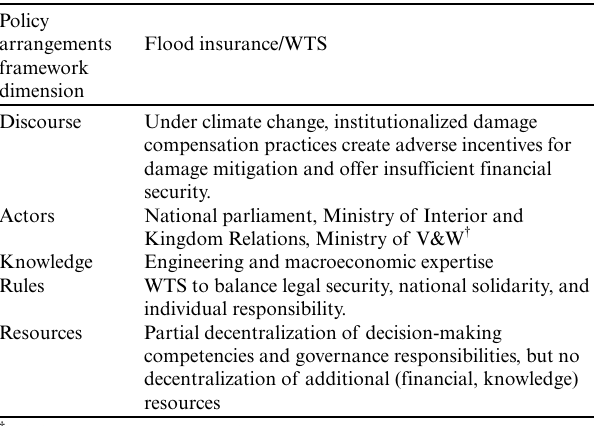
Table 3 . Changes in the Dutch policy arrangement brought about by discussions on flood insurance and the